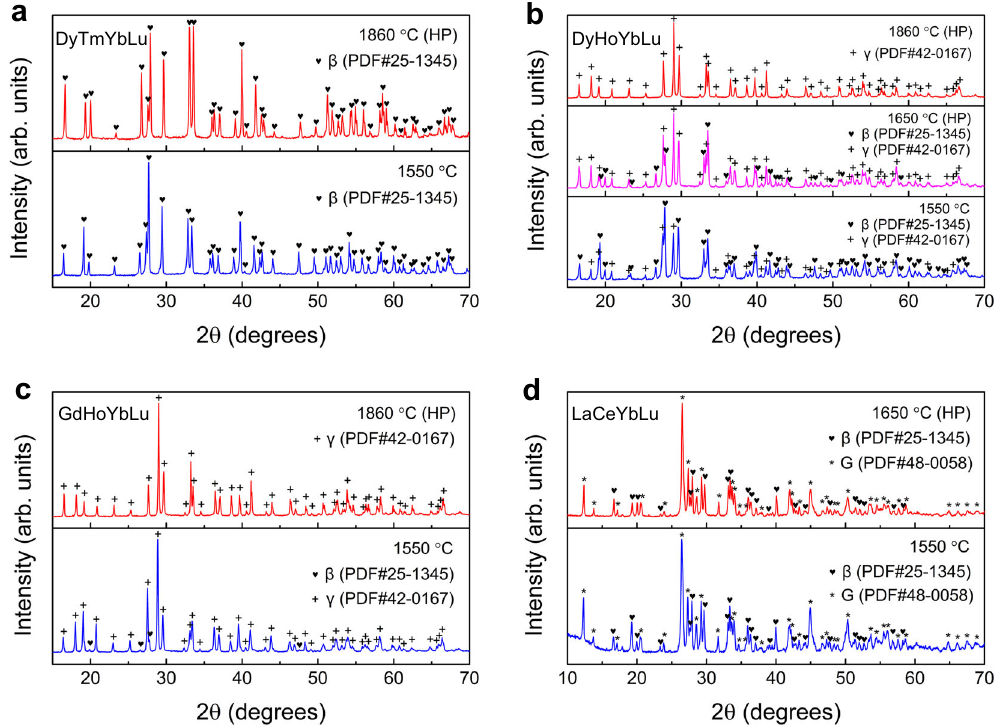
Fig. 1 | XRD patterns of the synthesized samples. Results for the composition of a (Dy 0.25 Tm 0.25 Yb 0.25 Lu 0.25 ) 2 Si 2 O 7 , b (Dy 0.25 Ho 0.25 Yb 0.25 Lu 0.25 ) 2 Si 2 O 7 , c (Gd 0.25 Ho 0.25 Yb 0.25 Lu 0.25 ) 2 Si 2 O 7 , and d (La x 1 Ce x 2 Yb x 3 Lu x 4 ) 2 Si 2 O 7 ( x 1+ x 2+ x